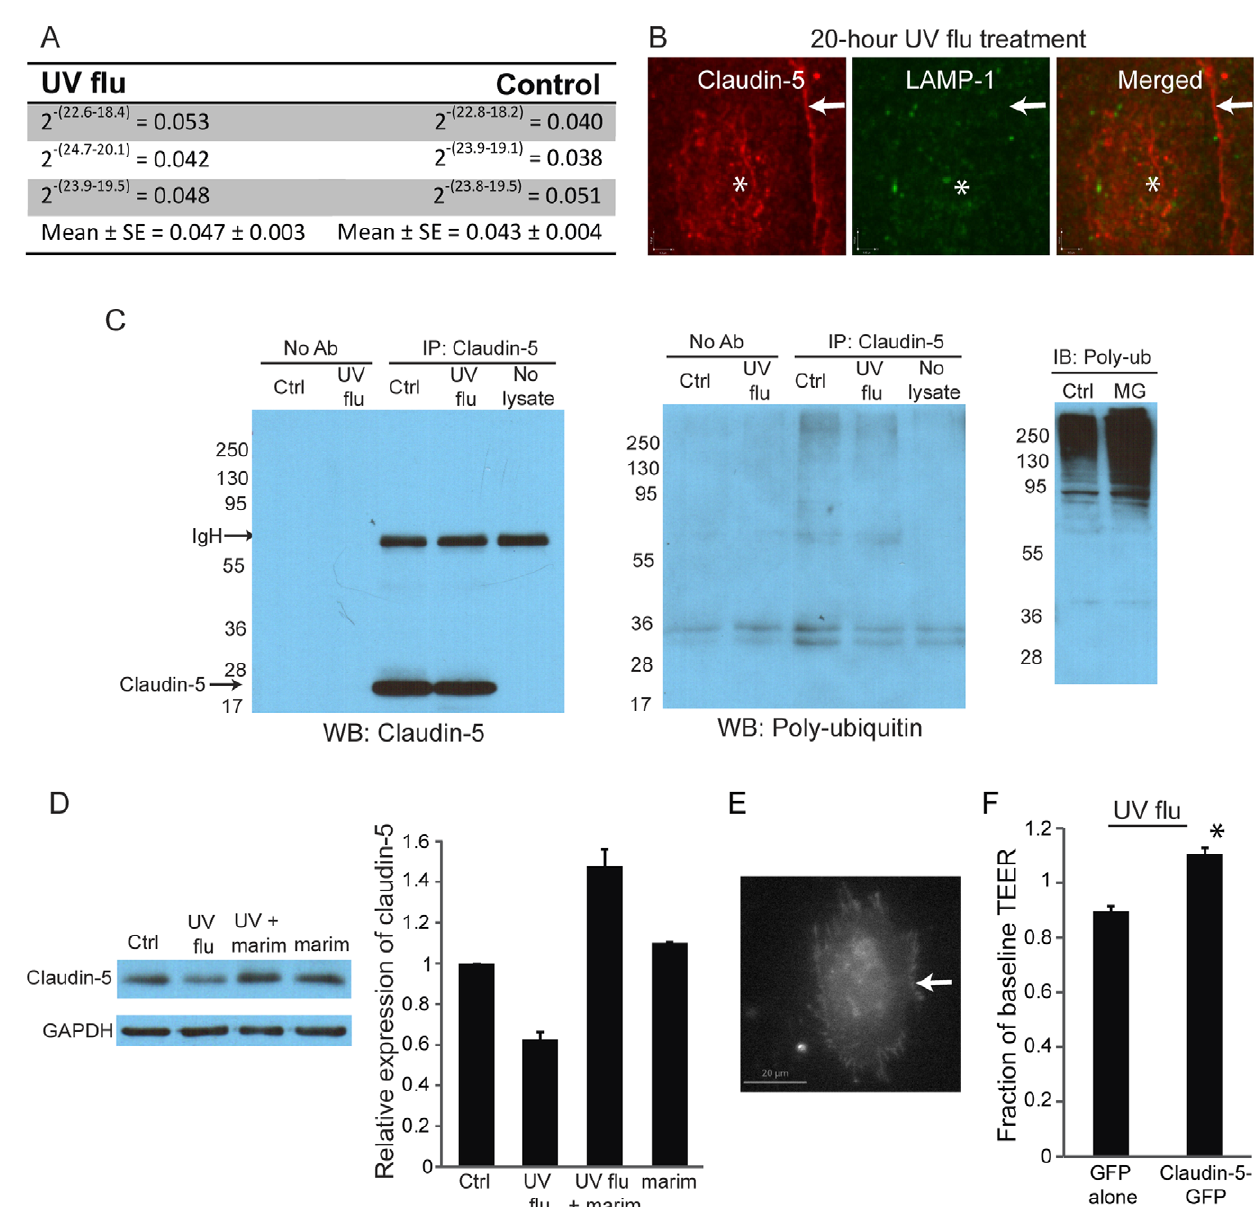
Figure 8. Influenza-induced loss of claudin-5 is due to cleavage by matrix metalloproteases. (A) The reduction in claudin-5 levels is not due to decreased transcription. Levels of claudin-5 mRNA were assessed by quantitative PCR 24 hours after infection with replication-deficient influenza (MOI 4). Results are presented using the comparative C T method using 18S rRNA as a control. Results are from 3 experiments, p . 0.05 for control versus infected. (B) Claudin-5 does not co-localize with lysosomes. Cells were infected with UV-irradiated influenza (MOI 8) for 16, 20, and 24 hours and were co-immunostained for LAMP1 and claudin-5. Images were from the 20-hour timepoint, but are reflective of all timepoints. Asterisks indicate cell nucleus, while arrows indicate cell membrane. Images are representative of 3 experiments. (C) Claudin-5 does not interact with poly- ubiquitin. The right-most blot shows the efficacy of the poly-ubiquitin antibody (FK1) since inhibition of the proteasome by MG-132 (MG) increases the expression of poly-ubiquitinated proteins in whole cell lysates. Cells were incubated with UV-influenza (MOI 8) for 24 hours. Whole cell lysates were immunoprecipitated for claudin-5 and blotted for poly-ubiquitin. IgH denotes the heavy chain of the IP antibody. Blots are representative of 3 experiments. (D) Inhibition of MMPs by marimastat blocks influenza-induced loss of claudin-5. Whole cell lysates were probed for claudin-5. Cells were treated with marimastat and infected with UV-flu (MOI 8) for 24 hours. Blot and quantitation are representative of 3 experiments. (E-F) Over- expression of claudin-5 blocks influenza-induced leak. Cells were transfected with either GFP or claudin-5 GFP. Arrow denotes membrane expression of claudin-5-GFP (A). Monolayers were then infected with UV-irradiated influenza (MOI 8) for 24 hours and the TEER was measured pre- and post- infection. Data are mean, SE for 3 experiments, *p , 0.05.